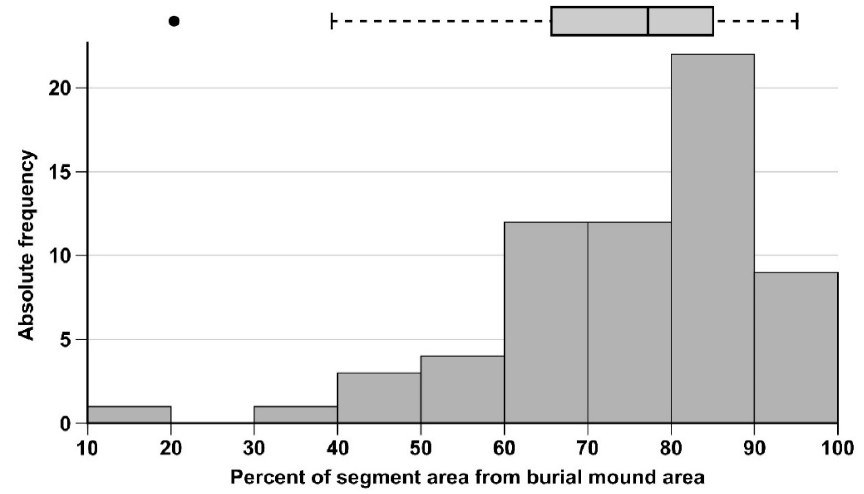
Figure 20. The accuracy statistics of the watershed segmentation for the northern study area. (a high-resolution version can be found at https://doi.org/10.6084/m9.figshare.11798703.v1)